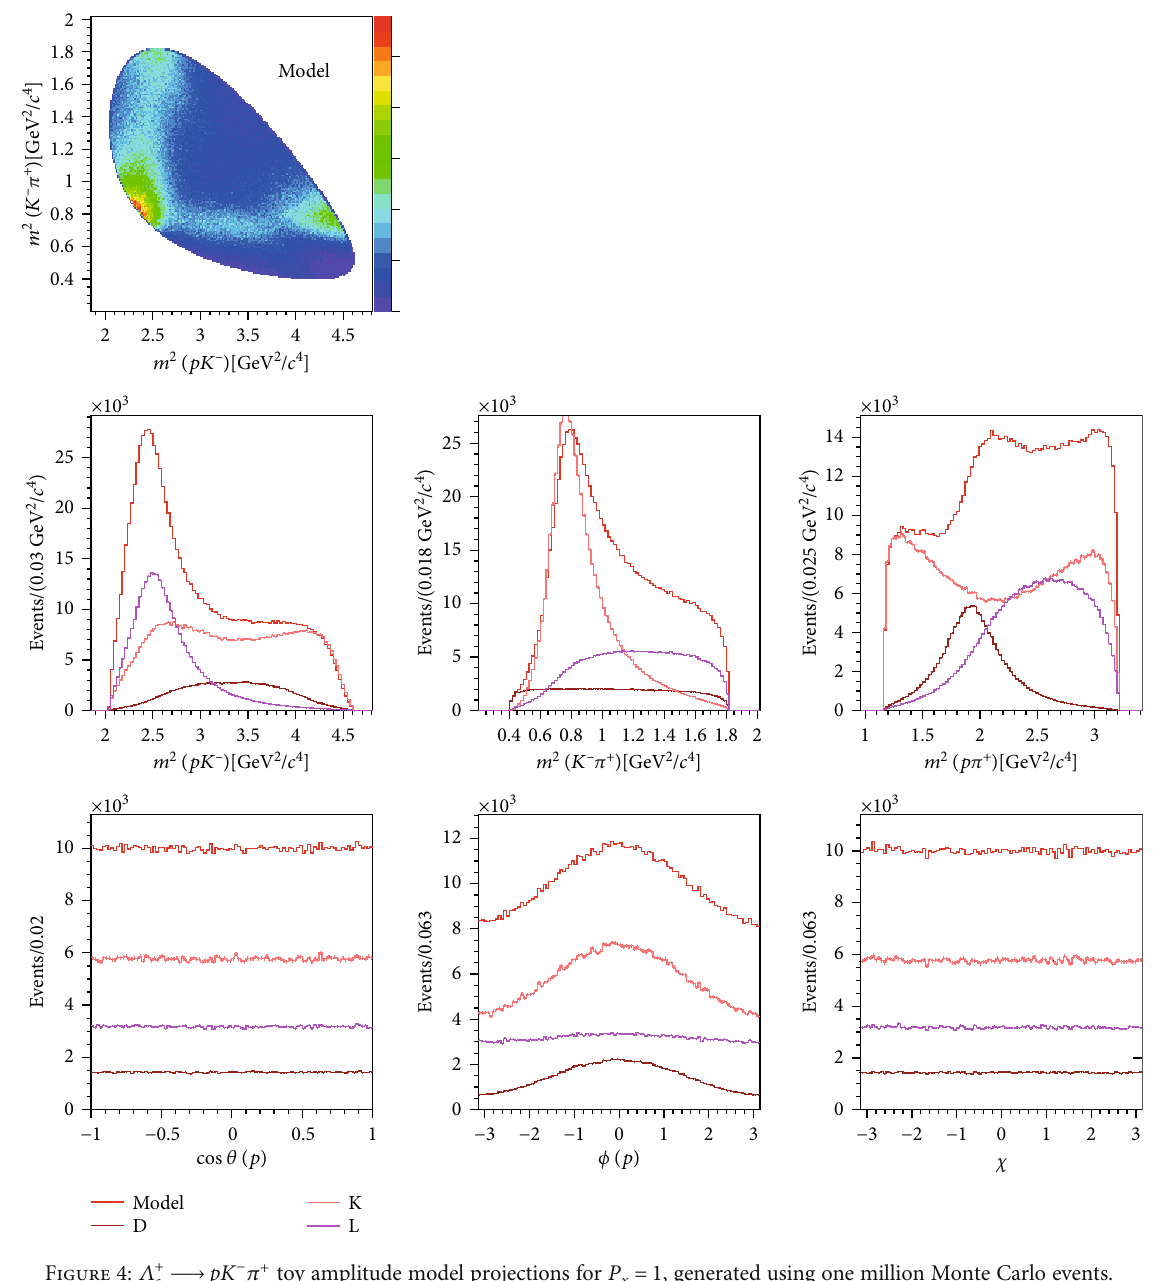
= 1 , generated using one million Monte Carlo x